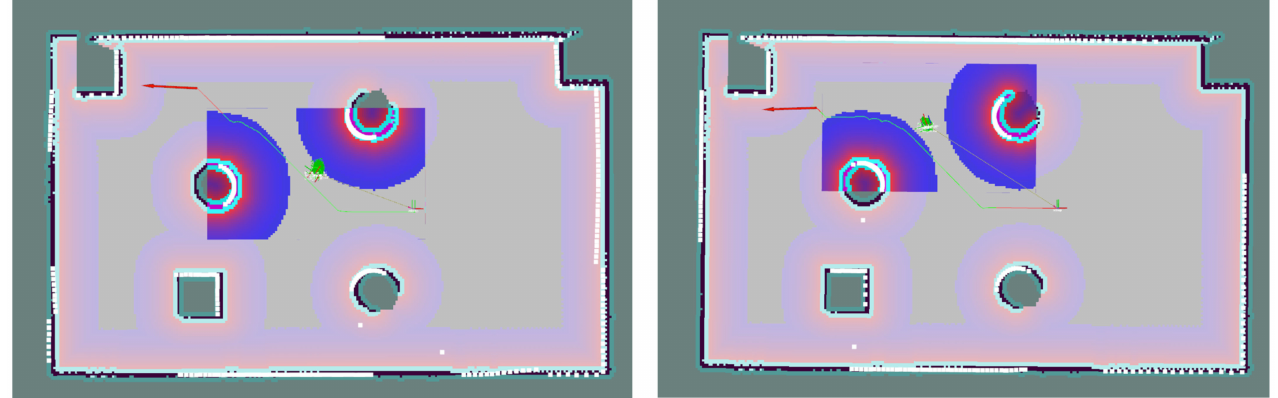
Figure 5. Point cloud correction before and after navigation map. The left figure shows before correction, and the right figure shows after correction, the white color shows the 2D laser point cloud data obtained after the conversion of 3D laser point cloud data, the green color shows the AMCL algorithm particle swarm, and the light purple part shows the cost map after the